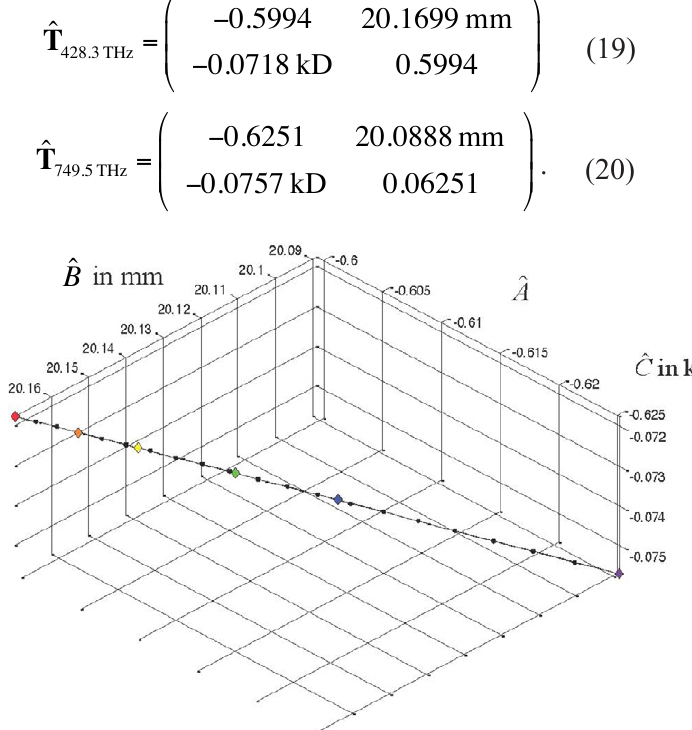
Figure 4. The transformed transference of the reduced eye in Hamiltonian space. The three axes represent ˆ A , ˆ B , ˆ A , ˆ B and ˆ C . The black dots represent frequencies spaced at intervals of 16.06 THz. The six diamonds represent the six coloured reference points. (The azimuth of 45° and elevation of 125° were chosen to exaggerate any possible curvature.)